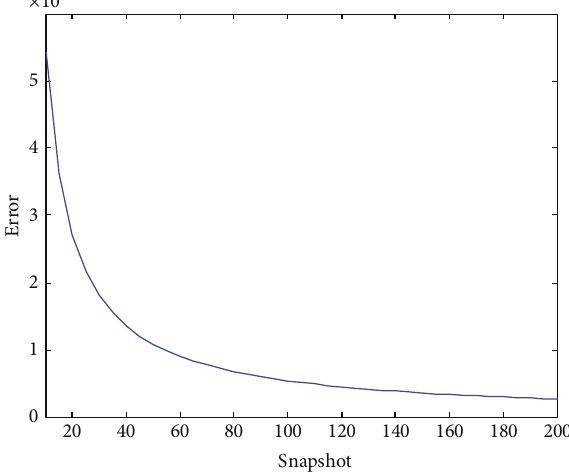
Figure 5: Theoretical CRB with respect to the change of θ and r .